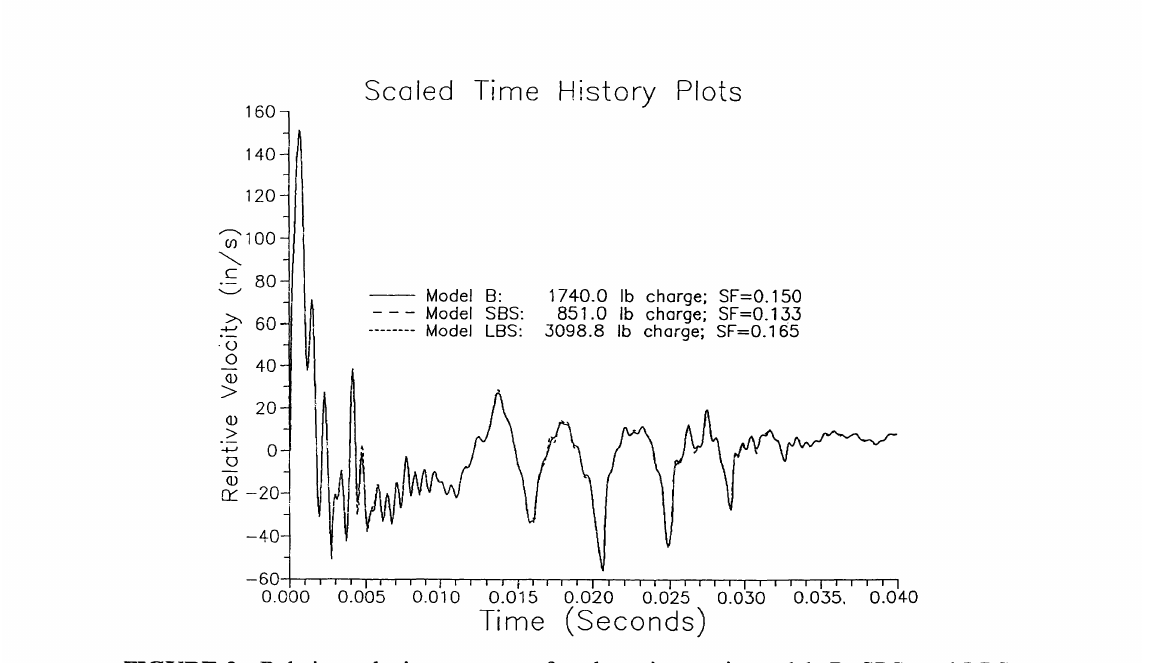
FIGURE 3 Relative velocity response of each equipment in models B, SBS, and